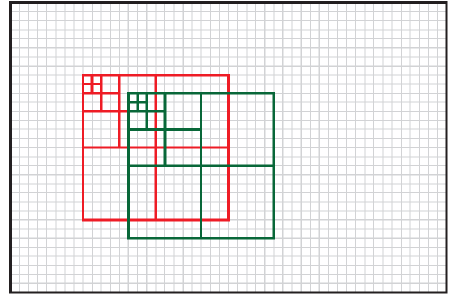
Figure 1. Sliding window aggregation